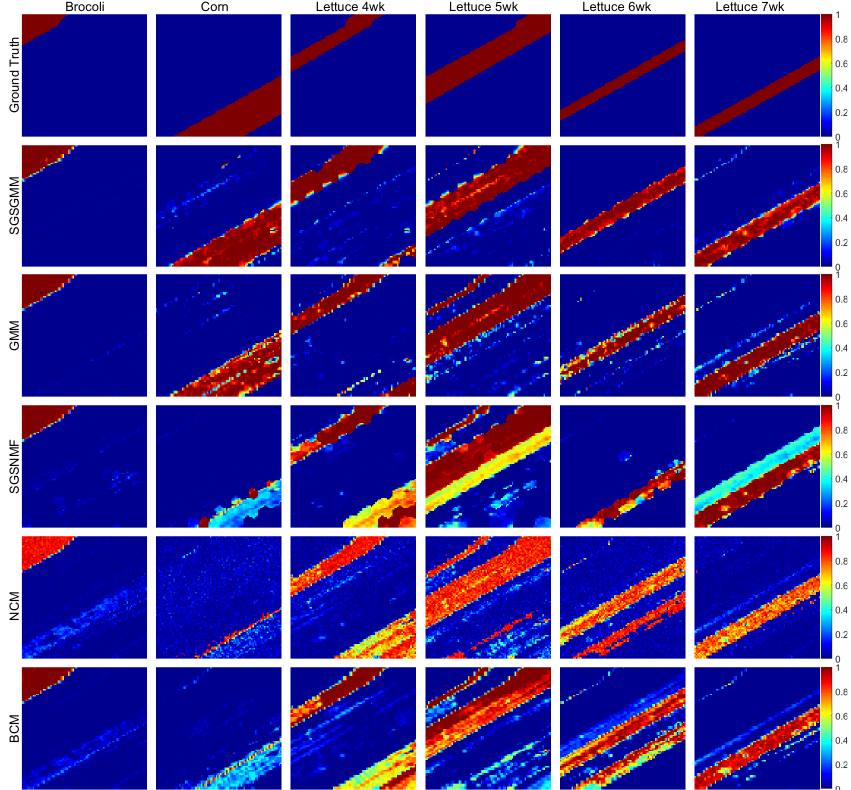
Figure 11. Abundance maps comparison for the ground truth, SGSGMM, GMM, SGSNMF, NCM, and